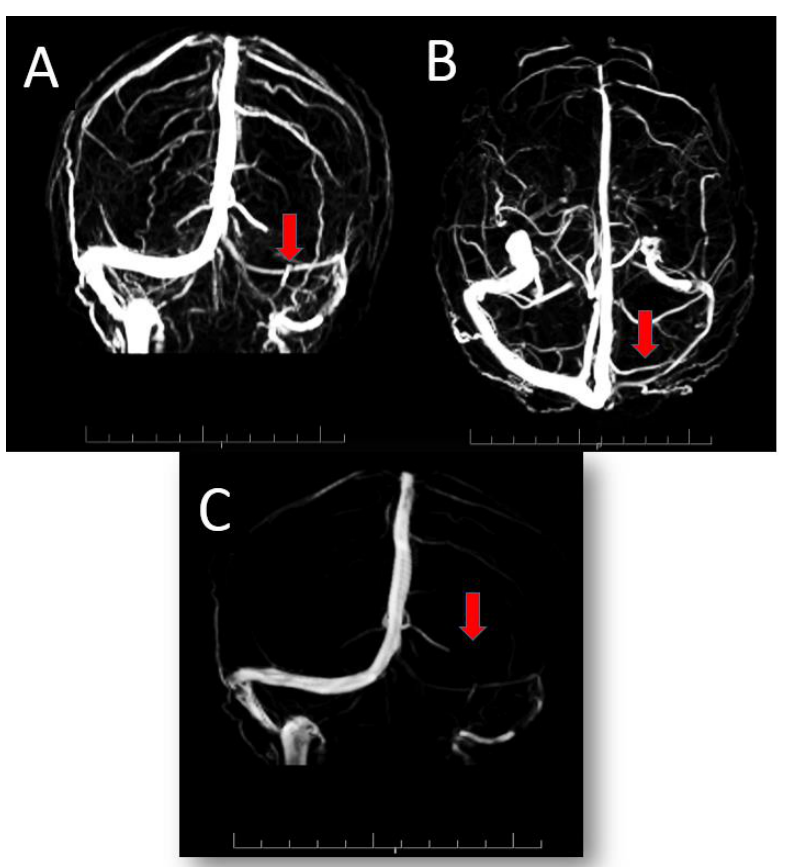
Figure 1. 3D reconstruction of venous angio-RM showing hypoplasia of left transverse sinus, indi- cated in ( A ) (Coronal), ( B ) (Caudocranial) and ( C ) (Sagittal) figures by the red arrows, in the absence of thrombus.